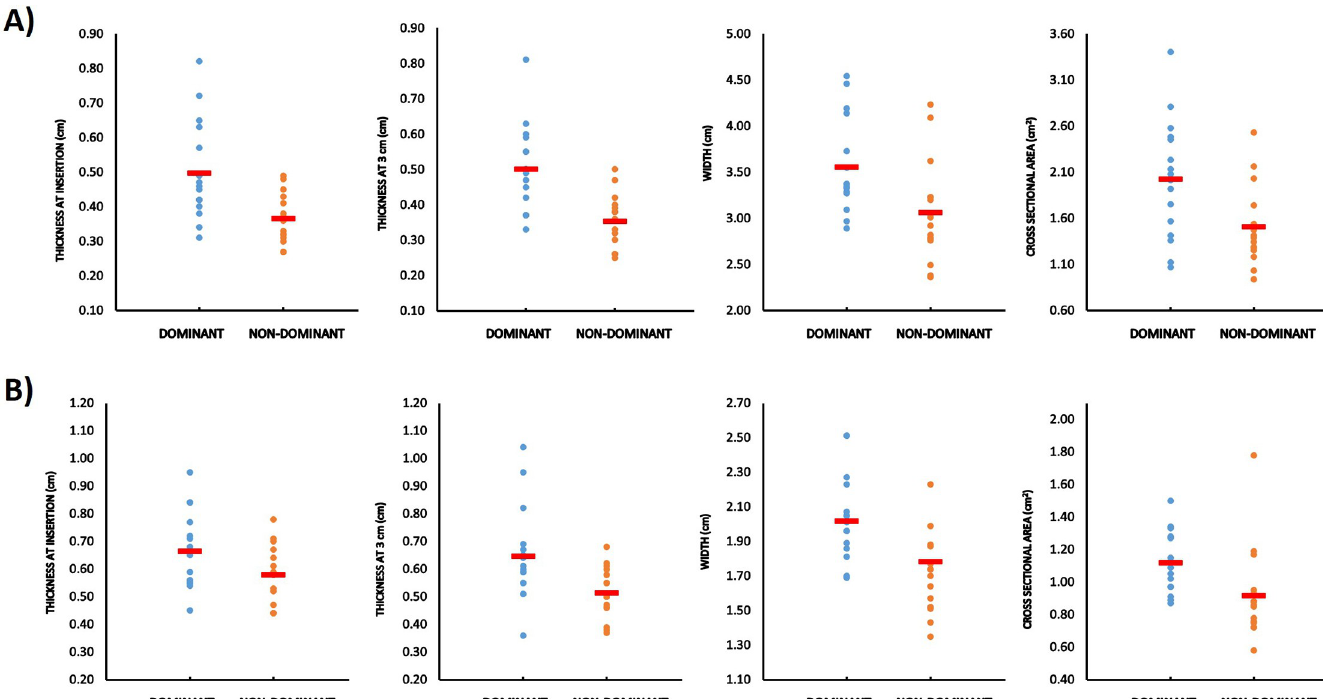
Fig 2. Significant differences of structural variables of patellar and Achilles tendons. A) Results of patellar tendon. B) Results of Achilles tendon. Individual Values and